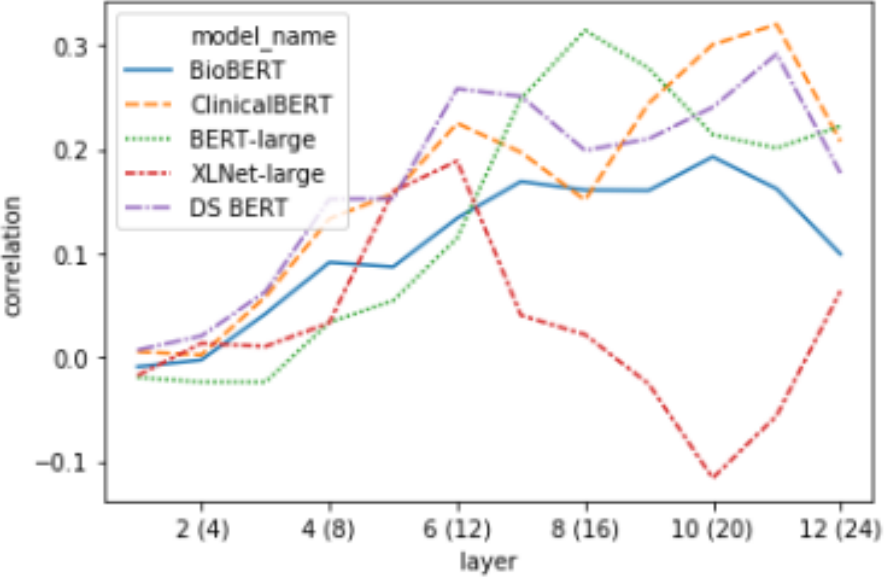
Figure 10. Correlation between the ground-truth model RDM and explanatory RDMs constructed using the absolute difference between each sentence’s mean-pooled token